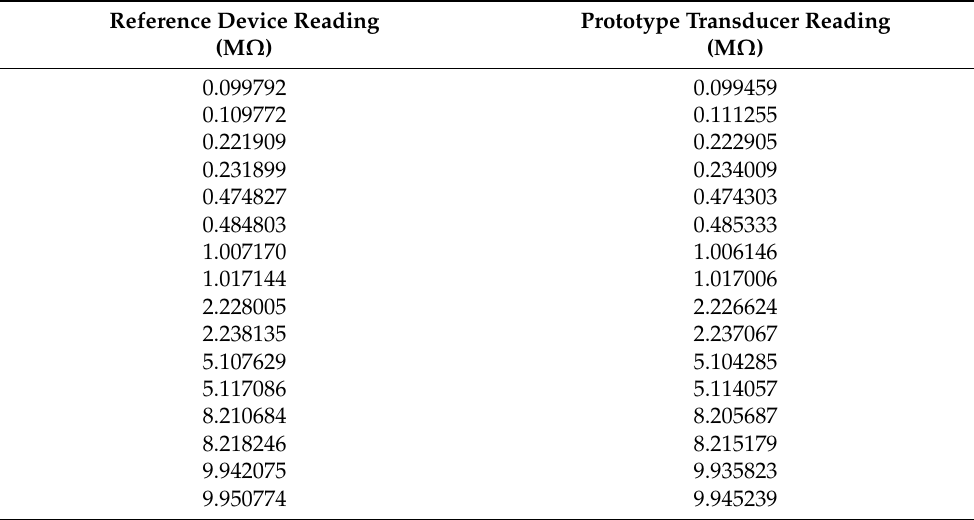
Table 1. Full original data showing reading of series of test resistors when measured by reference device compared to value indicated by prototype transducer; averaged values ( n = 100), rounded to 6 decimal places.